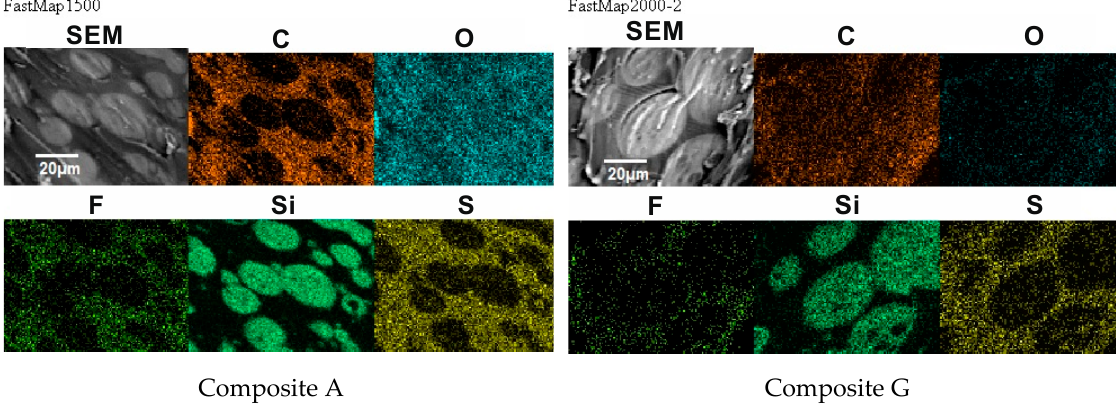
Figure 11. Distribution of elements in the composite film prepared using EC/DMC as solvent ( Composite A ) and the composite film where that solvent was replaced with reactive IL 3 ( Composite G ).